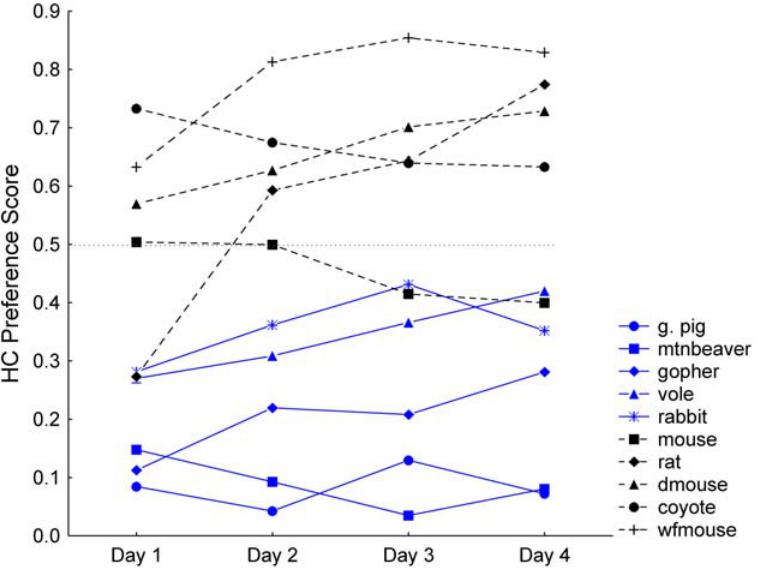
Figure 4. Daily HC preference scores. Species means for each day of testing. Blue symbols (solid lines) are herbivores; black symbols (dashed lines) are omnivores.